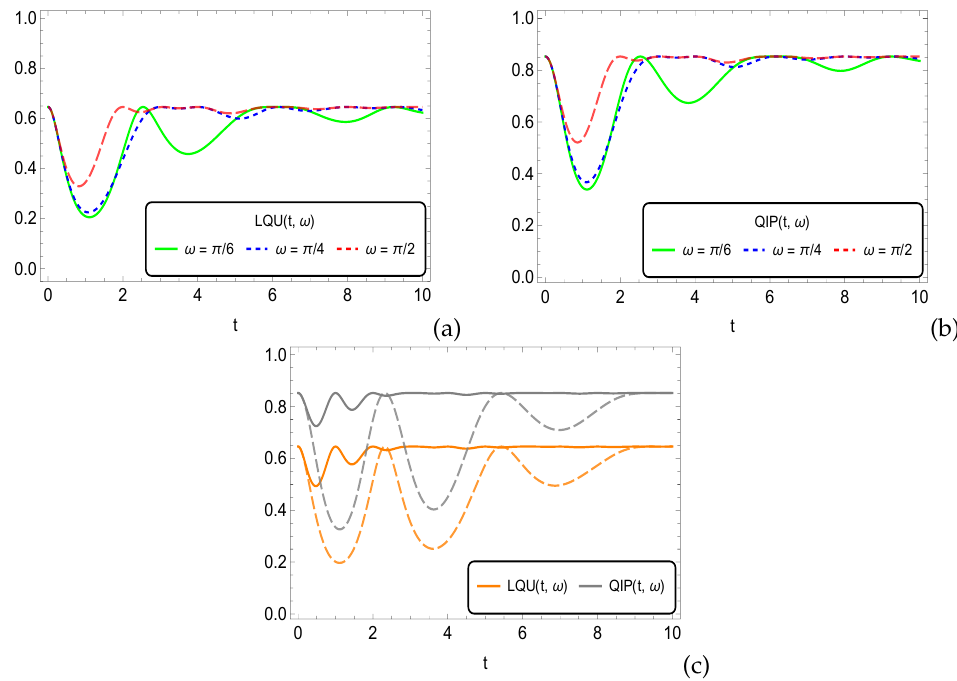
Figure 1. LQU and QIP as a function of time versus different values of ω . LQU ( a ) and QIP ( b ). Graph ( c ): ω = π (solid lines) and ω = π /10 (dashed lines). For all plots r = 0.9, b = 0.5, and ∆ =